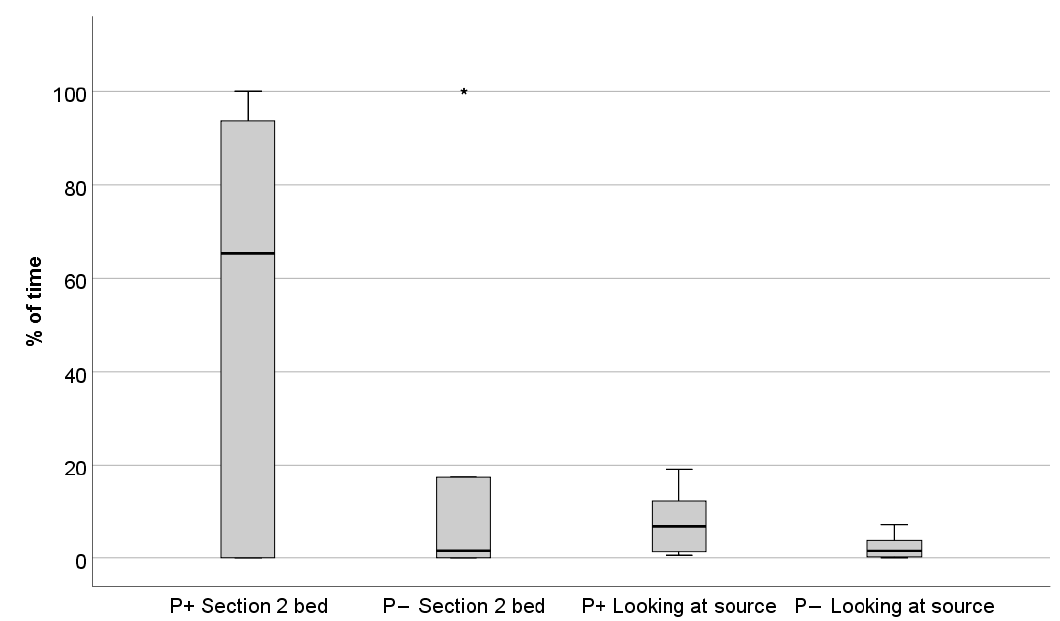
Figure 3. Percentage of time spent by the dogs in the Section 2 bed and the percentage of time spent by the dogs looking at the audio source in the two conditions (P+: auditory enrichment with a human present, sitting behind the speakers; P − : auditory enrichment without human presence). Section 2 bed was located in the front part of the enclosure. The dogs spent significantly more time in the Section bed 2 in the presence of the human (Wilcoxon test: p = 0.047) and spent significantly more time looking at the audio source when the human was present and mimicking reading (Wilcoxon test: p = 0.004). * depicts outlier.